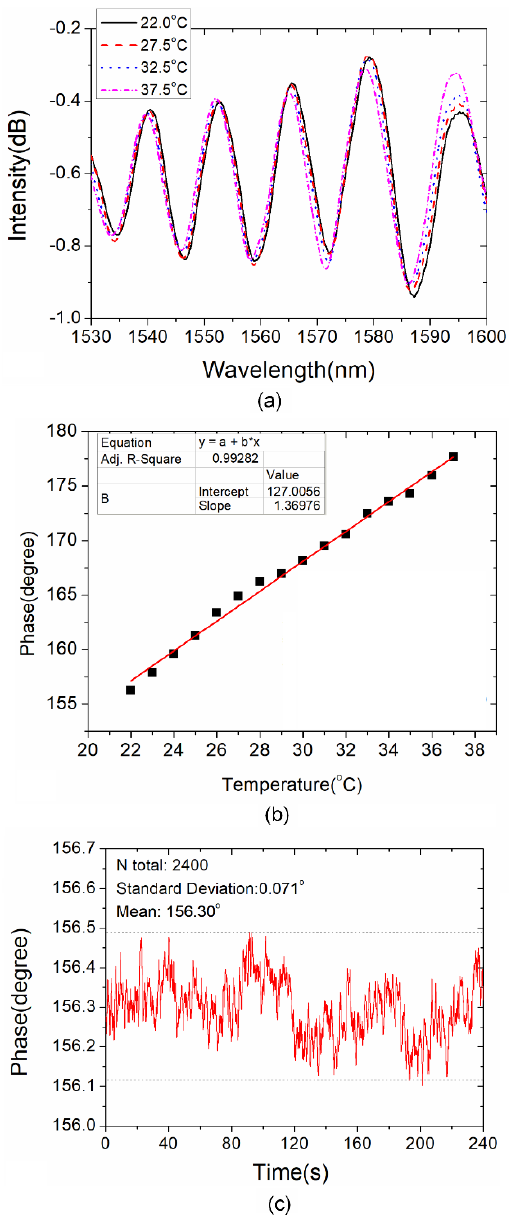
Figure 7. Temperature cross-sensitivity of WWFT-based interferometer: ( a ) Transmission spectra as temperature increases from 22 °C to 37.5 °C; ( b ) Phase shift versus temperature for the sensor with L = 41.2 mm and L vp = 20 μ m; ( c ) Continuous monitoring of phase fluctuation at 22.0 °C.